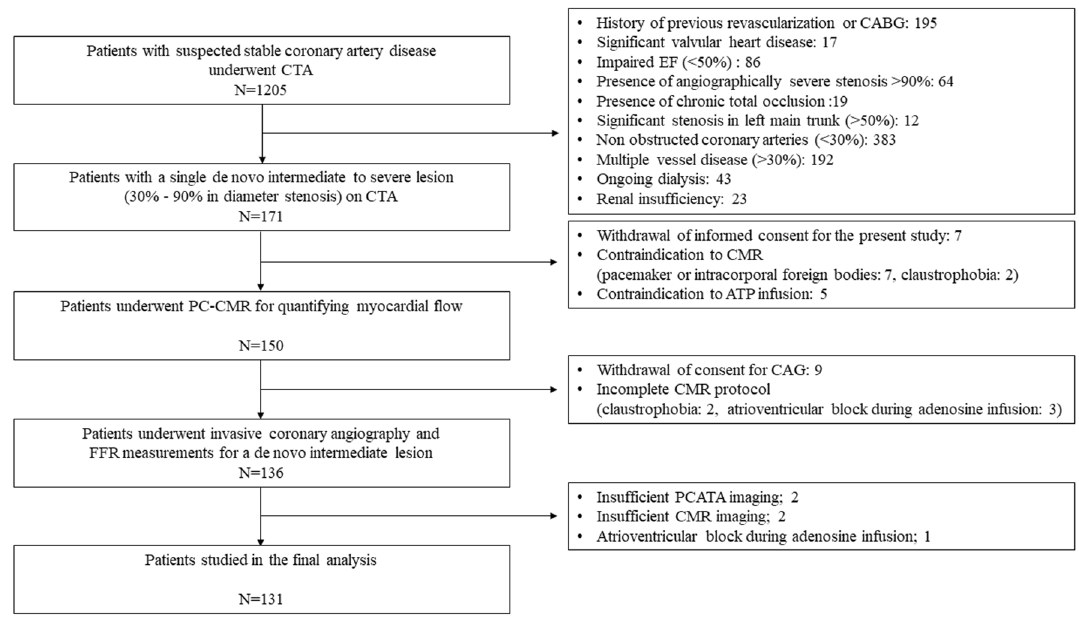
Figure 1. Study flow chart. Figure shows the screening and enrollment process with a total of 131 patients in the final